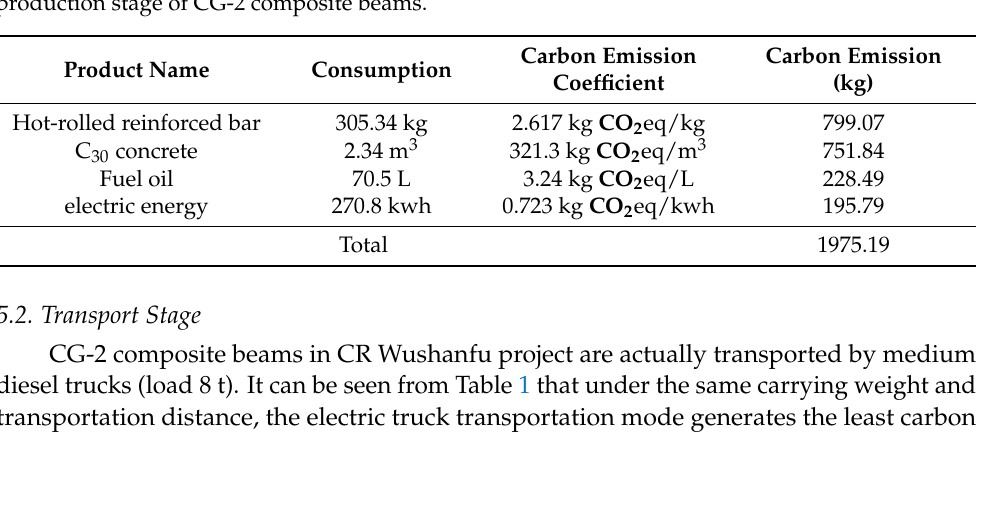
Table 4. Total carbon emissions generated by raw materials and energy consumed during the pro- duction stage of CG-2 composite beams.